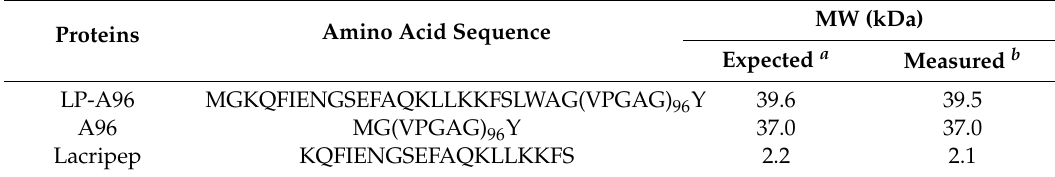
Table 1. Molecular information of LP-A96, A96, and